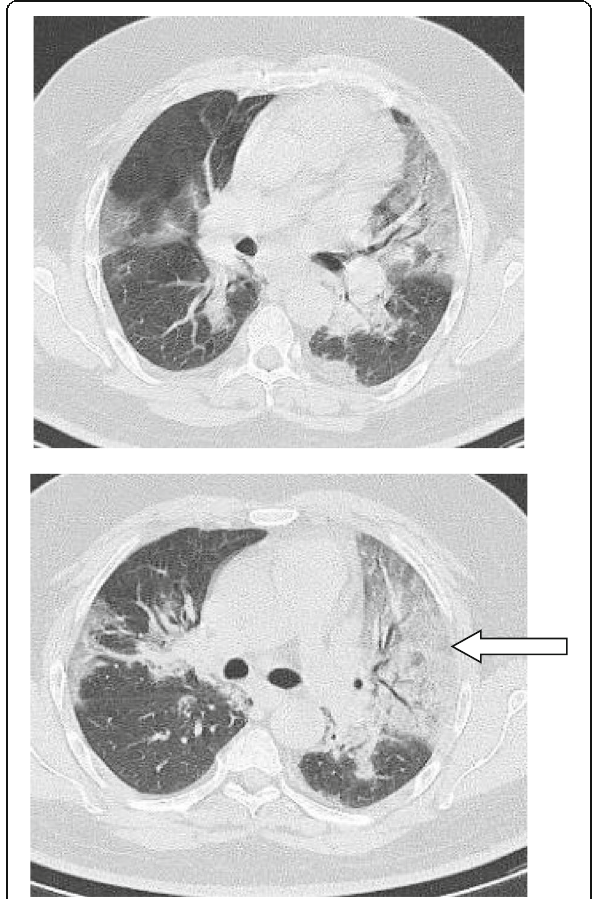
Fig. 3 Wide areas of ground glass infiltration with air bronchogram. Patient with COVID-19 pneumonia 8 days after onset of symptoms